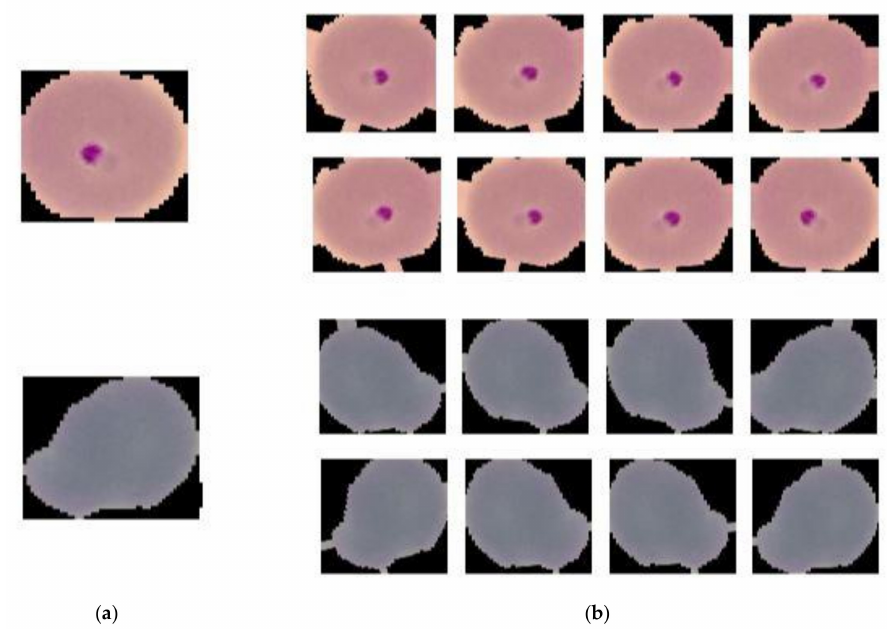
Figure 2. Image before resizing and performing augmentation is depicted in ( a ) and image after resizing and applying augmentation is depicted in ( b